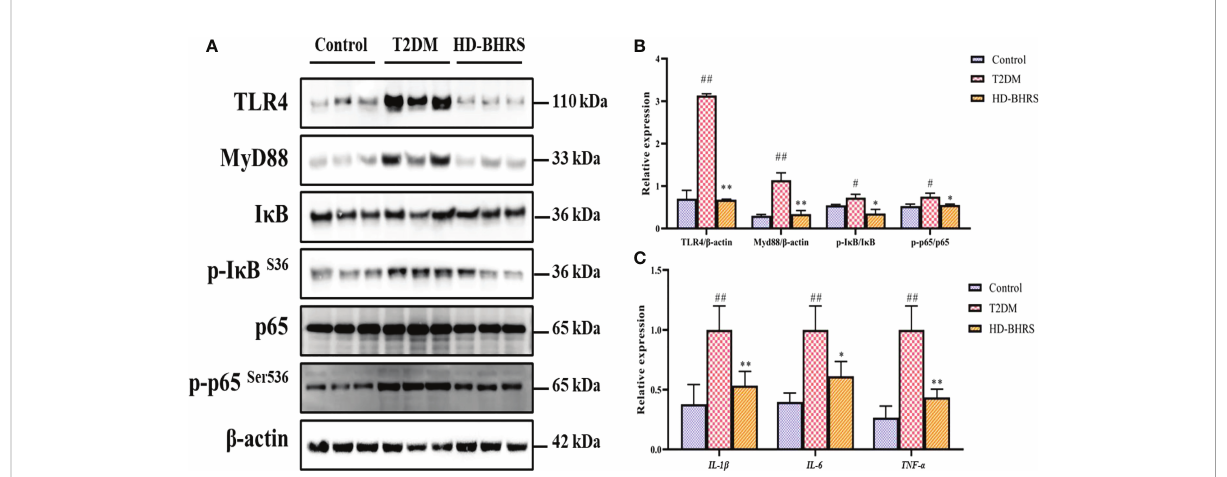
FIGURE 4 BHRS treatment inhibited the activation of TLR4/NF- k B signaling pathway. (A, B) The protein levels of TLR4 and MyD88 and the phosphorylation of I k B, and NF- k Bp65 in liver were detected using western blot and the relative expressions of proteins were quanti fi ed based on grayscale values using Image J analysis software. b -actin was used as the loading control. For detecting the phosphorylation of proteins, the relative expression was calculated by the speci fi c value of phosphorylated protein to total protein. (C) The gene expression of pro-in fl ammatory cytokines ( IL-1 b , IL-6 and TNF- a ) in liver were detected using qPCR. # : p < 0.05 as compared to the control group; ## : p < 0.01 as compared to the control group; *: p < 0.05 as compared to the T2DM group; **: p < 0.01 as compared to the T2DM